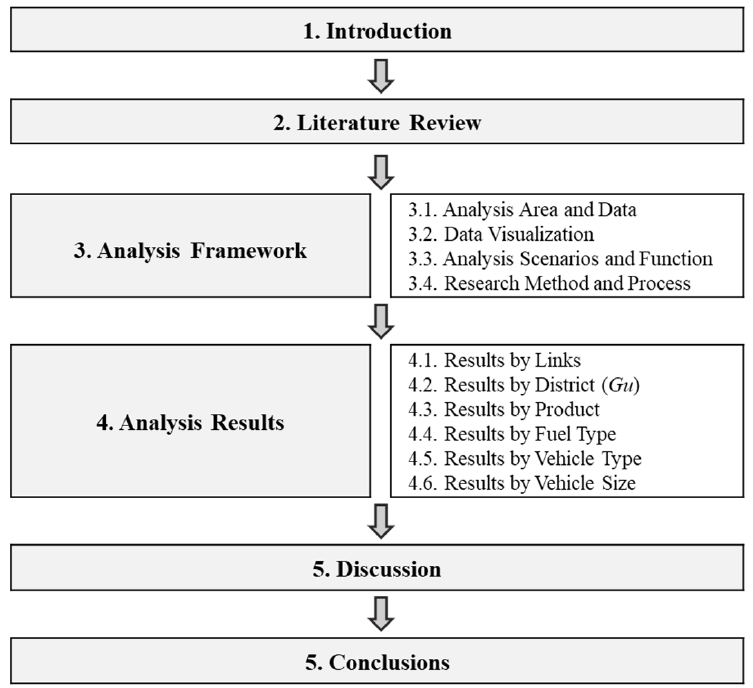
Figure 1. Flowchart showing the process adopted in this study.